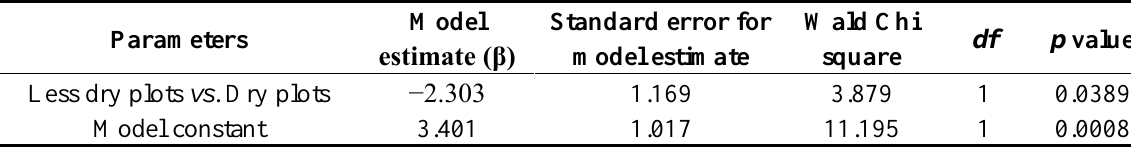
Table 2. Results from binary logistic regression, where a status plant (live or dead) was selected as dependent variable and ASWSC of plots (dry or less dry) was considered as independent variable (Log likelihood ratio value: 26.830, Cox and Snell R 2 = 0.101, Nagelkerke R 2 = 0.206, N = 47).